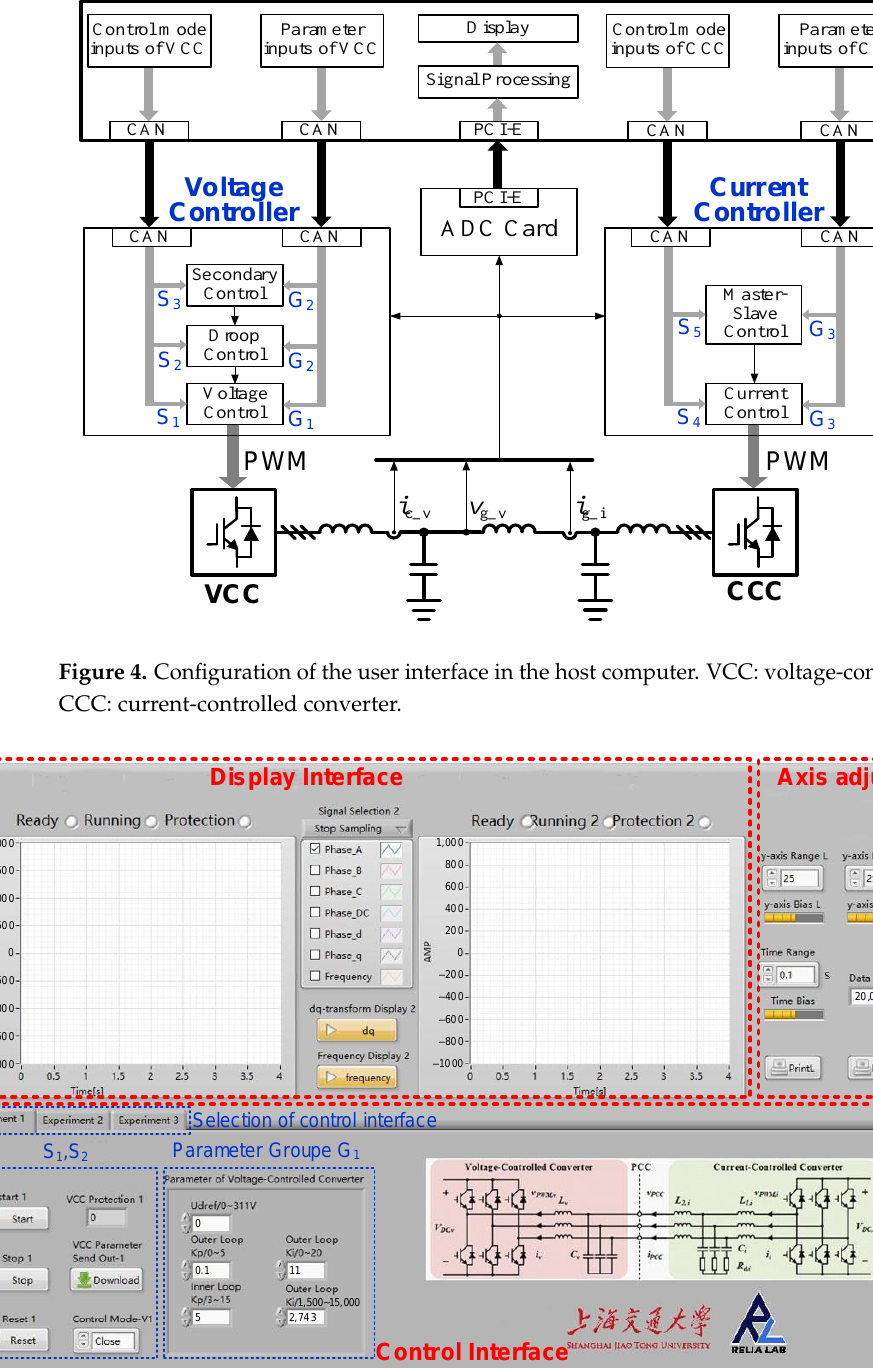
Figure 5. The actual user interface of the proposed emulation approach.